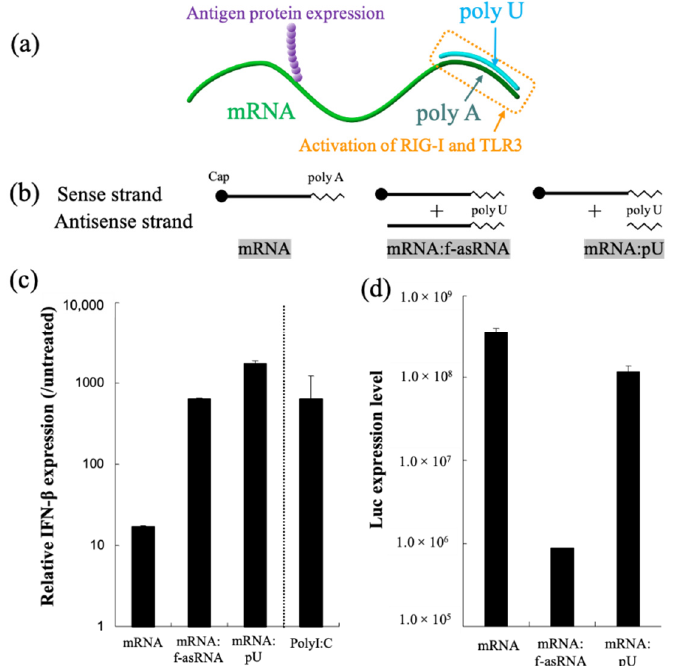
Figure 6. RNA hybridization as a novel technology to induce a specific adjuvant effect. ( a ) Partially double-stranded mRNA with poly U hybridized to poly A simultaneously expresses antigen protein and stimulates RIG-I and TLR3. ( b – d ) Functionalities of partially double-stranded mRNA. ( b ) Luciferase mRNA without hybridization(mRNA), mRNA hybridized with full-length antisense RNA (mRNA:f-asRNA), and mRNA hybridized with poly U (mRNA:pU). ( c ) Immunostimulatory property. ( d ) Translational efficiency. After luciferase mRNA introduction to cultured dendritic cells, levels of interferon β transcript ( c ) and Luc protein expression were quantified. Reproduced with permission from [123] , Elsevier, 2018.